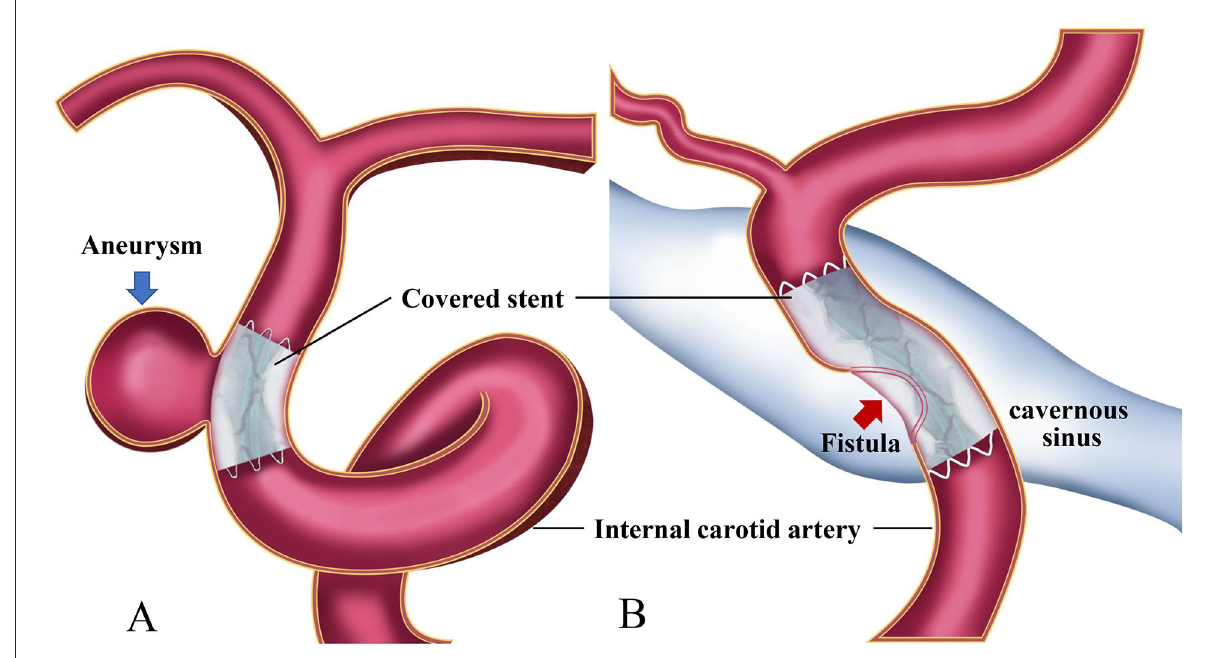
FIGURE1 Diagrams of covered stent insertion in the treatment of a cerebral aneurysm (A) and a carotid cavernous fistula (B)